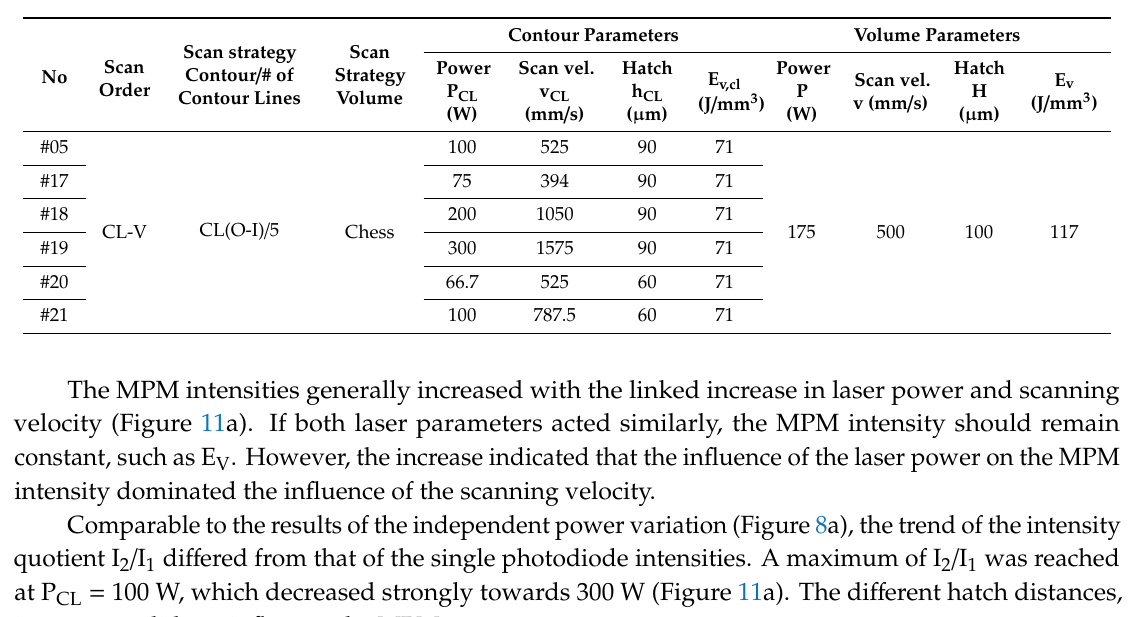
Table 5. Varying the main laser parameters, E V =